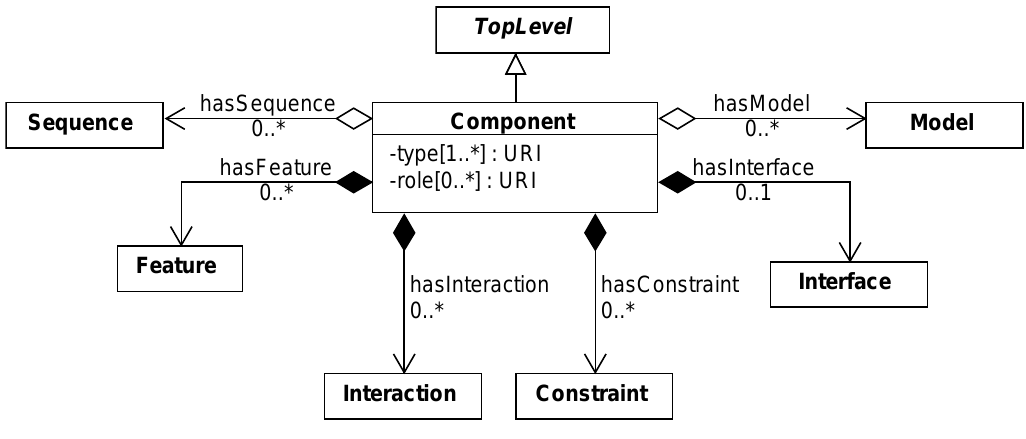
Figure 8: Diagram of the Component class and its associated